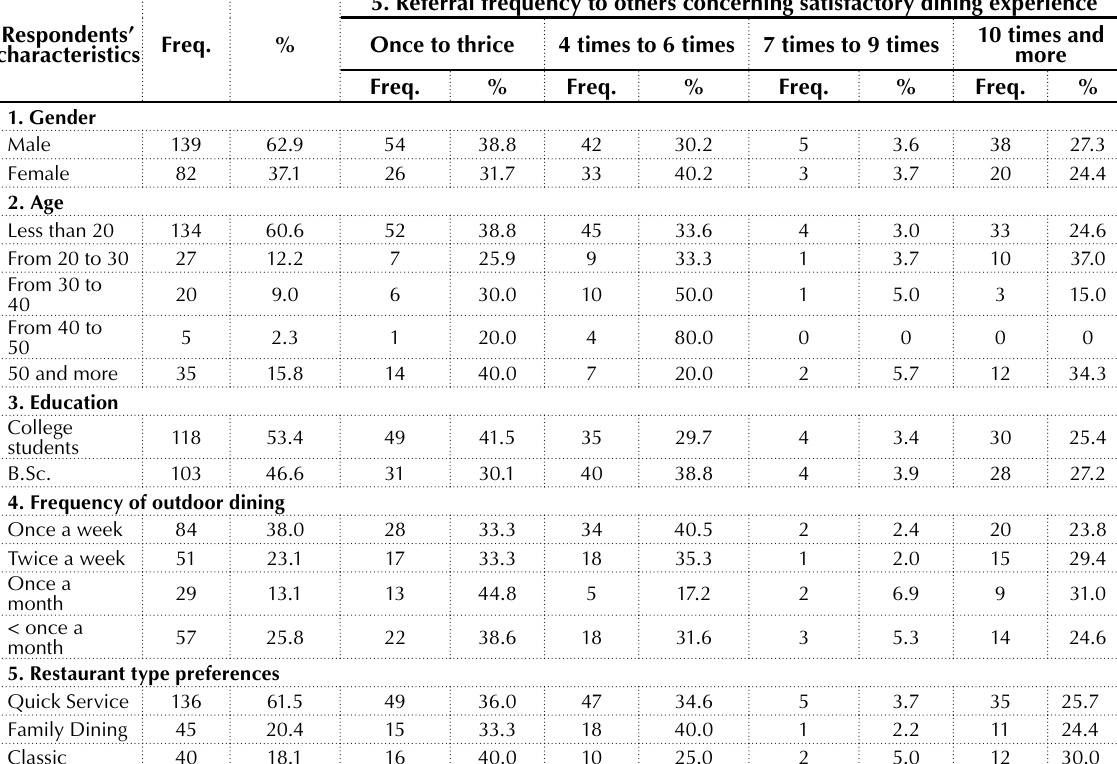
Table 4. Associating WOM referral intentions to consumers’ characteristics Respondents’ characteristics